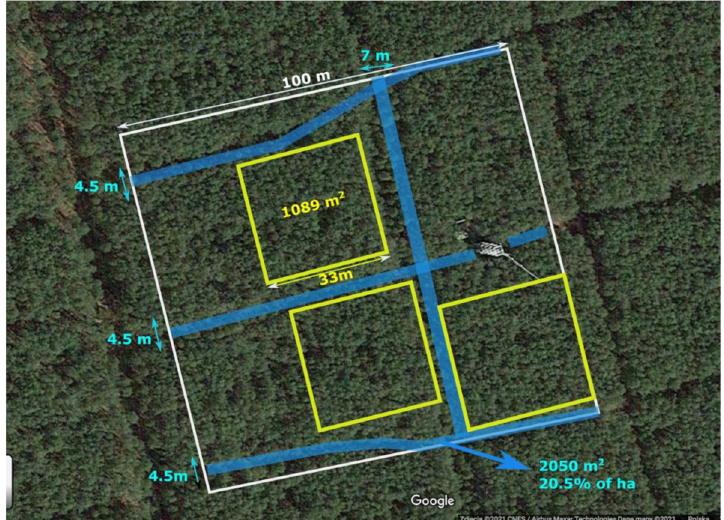
Figure 1. Photomap showing the distribution of the experimental plots at which the number of trees and DBH were measured (yellow squares). Five groups were established within the white square; each group had five trees with dendrometers installed. The flux tower is located near the center of the right edge of the white square. Blue stripes represent treeless areas or birch plantations (for the purpose of fire protection). Source: google